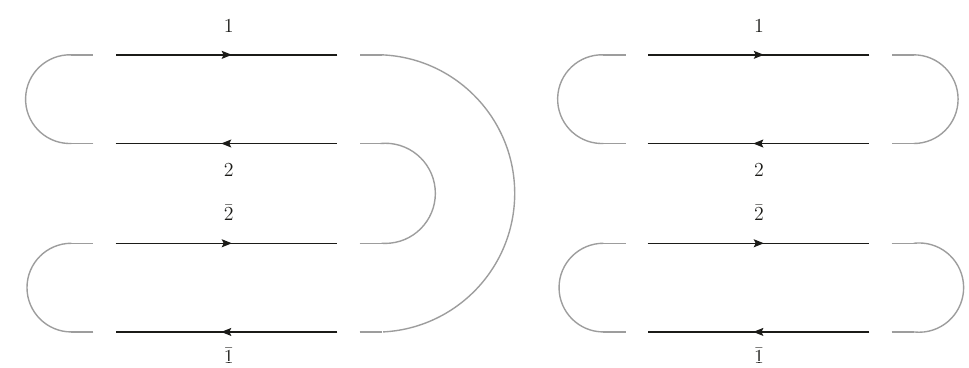
Figure 5. The two possible ways of color connecting the four Wilson lines. On the left is ] i , while on the right is C C ¯21 ≡ h tr[ V 1 V † V ¯2 V † ¯1 2 an arbitrary time t . The grey lines at the beginning and end indicate the colour